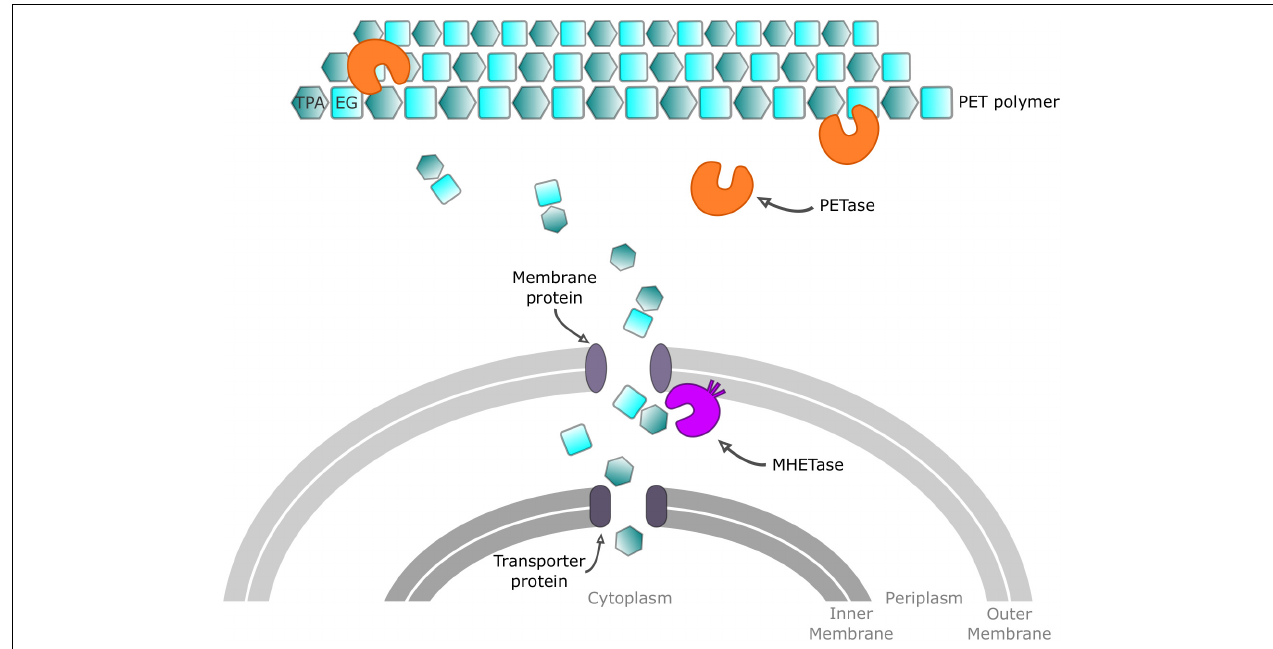
FIGURE 2 | Proposed mechanism for PET processing in Ideonella sakaiensis . Extracellular PETase enzyme acts on PET polymer chains to give oligomeric mono-(2-hydroxyethyl) terephthalate (MHET), the monoester of terephthalic acid (TPA) and ethylene glycol (EG). Intermediates are transported through a membrane protein before reaching MHETase, which degrades MHET into TPA and EG. Finally, monomers are transported into the cytoplasm to be metabolized.